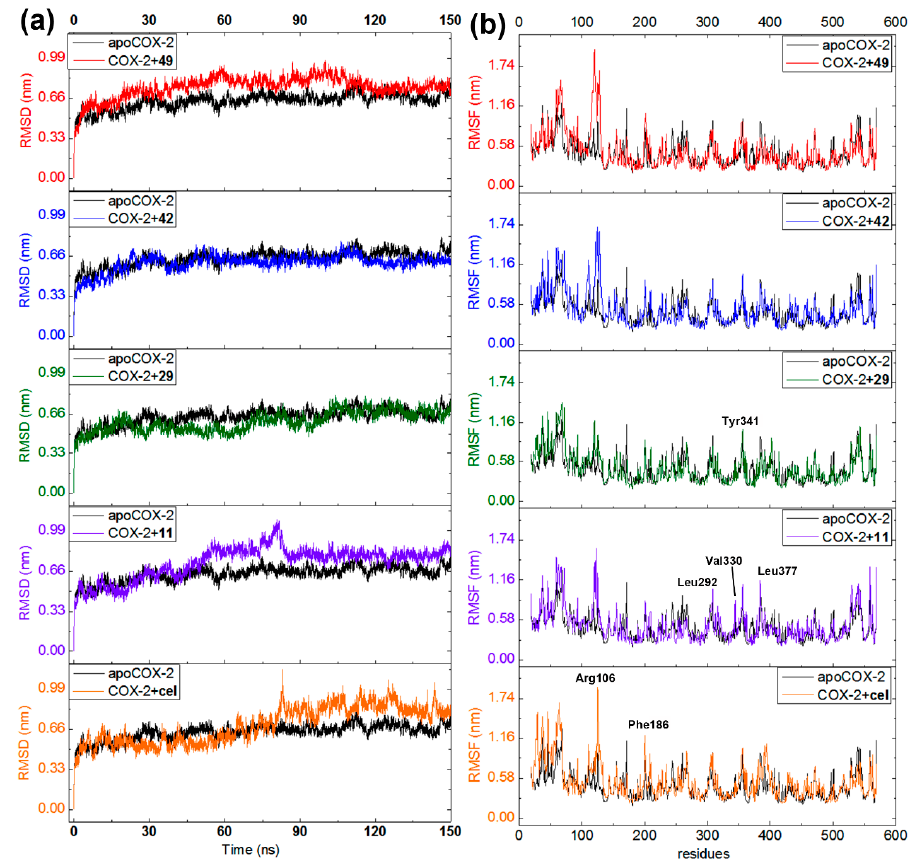
Figure 7. Molecular dynamics (MD) simulations during 150 ns for COX-2 apoenzyme (black line) and docked separately with 11 (purple line), 29 (green line), 42 (blue line), 49 (red line), and celecoxib (orange line). ( a ) Root mean square deviations (RMSD) along MD-simulated trajectories. ( b ) Root mean quadratic fluctuations (RMSF) of COX-2 residues (chain A) along MD-simulated trajectories. Fluctuations of the C α atomic positions for each residue of the enzyme was explored through the root mean square fluctuation (RMSF). It was used to scrutinize the flexibility and secondary structure of the COX-2 enzyme under binding with the best-docked 2-arylbenzofurans. Thus, lower RMSF values implied constrained regions whereas higher RMSF values denoted more flexibility. All